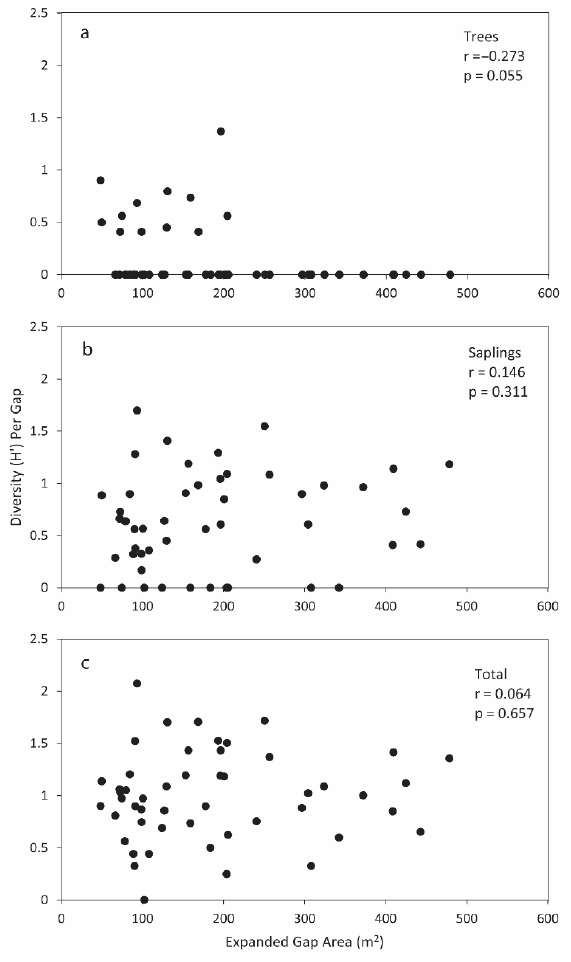
Figure 3. Pearson correlation between expanded gap area and Shannon diversity for ( a ) trees (live stems ≥ 10 cm dbh), ( b ) saplings (live woody stems ≥ 1 m height, <10 cm dbh), and ( c ) total stems (trees and saplings) in a montane Pinus palustris woodland.